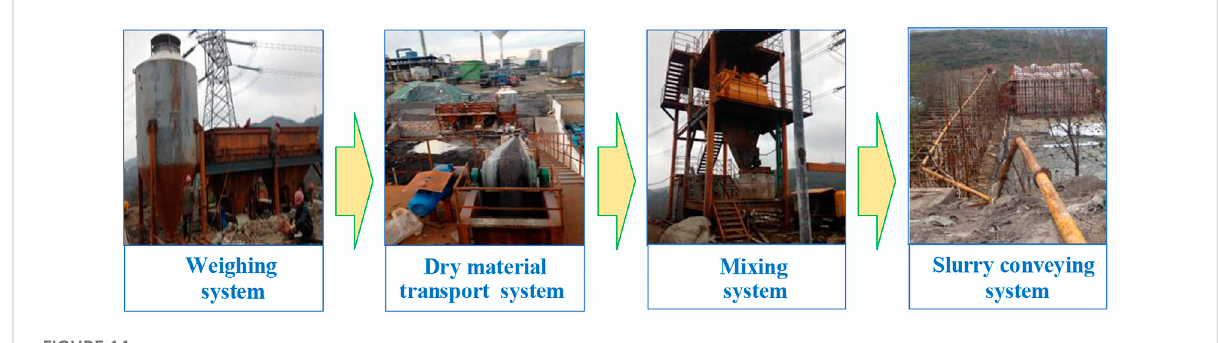
FIGURE 14 Arti fi cial pillar back fi lling system.